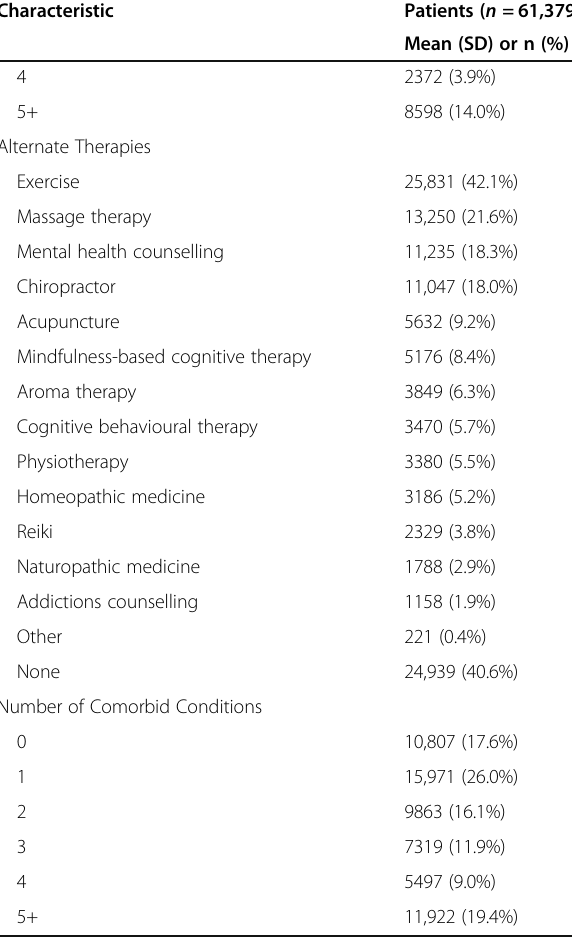
Table 1 Sociodemographic and medical characteristics of 61,379 patients seeking medical cannabis certification from CB2 Insights evaluation clinics